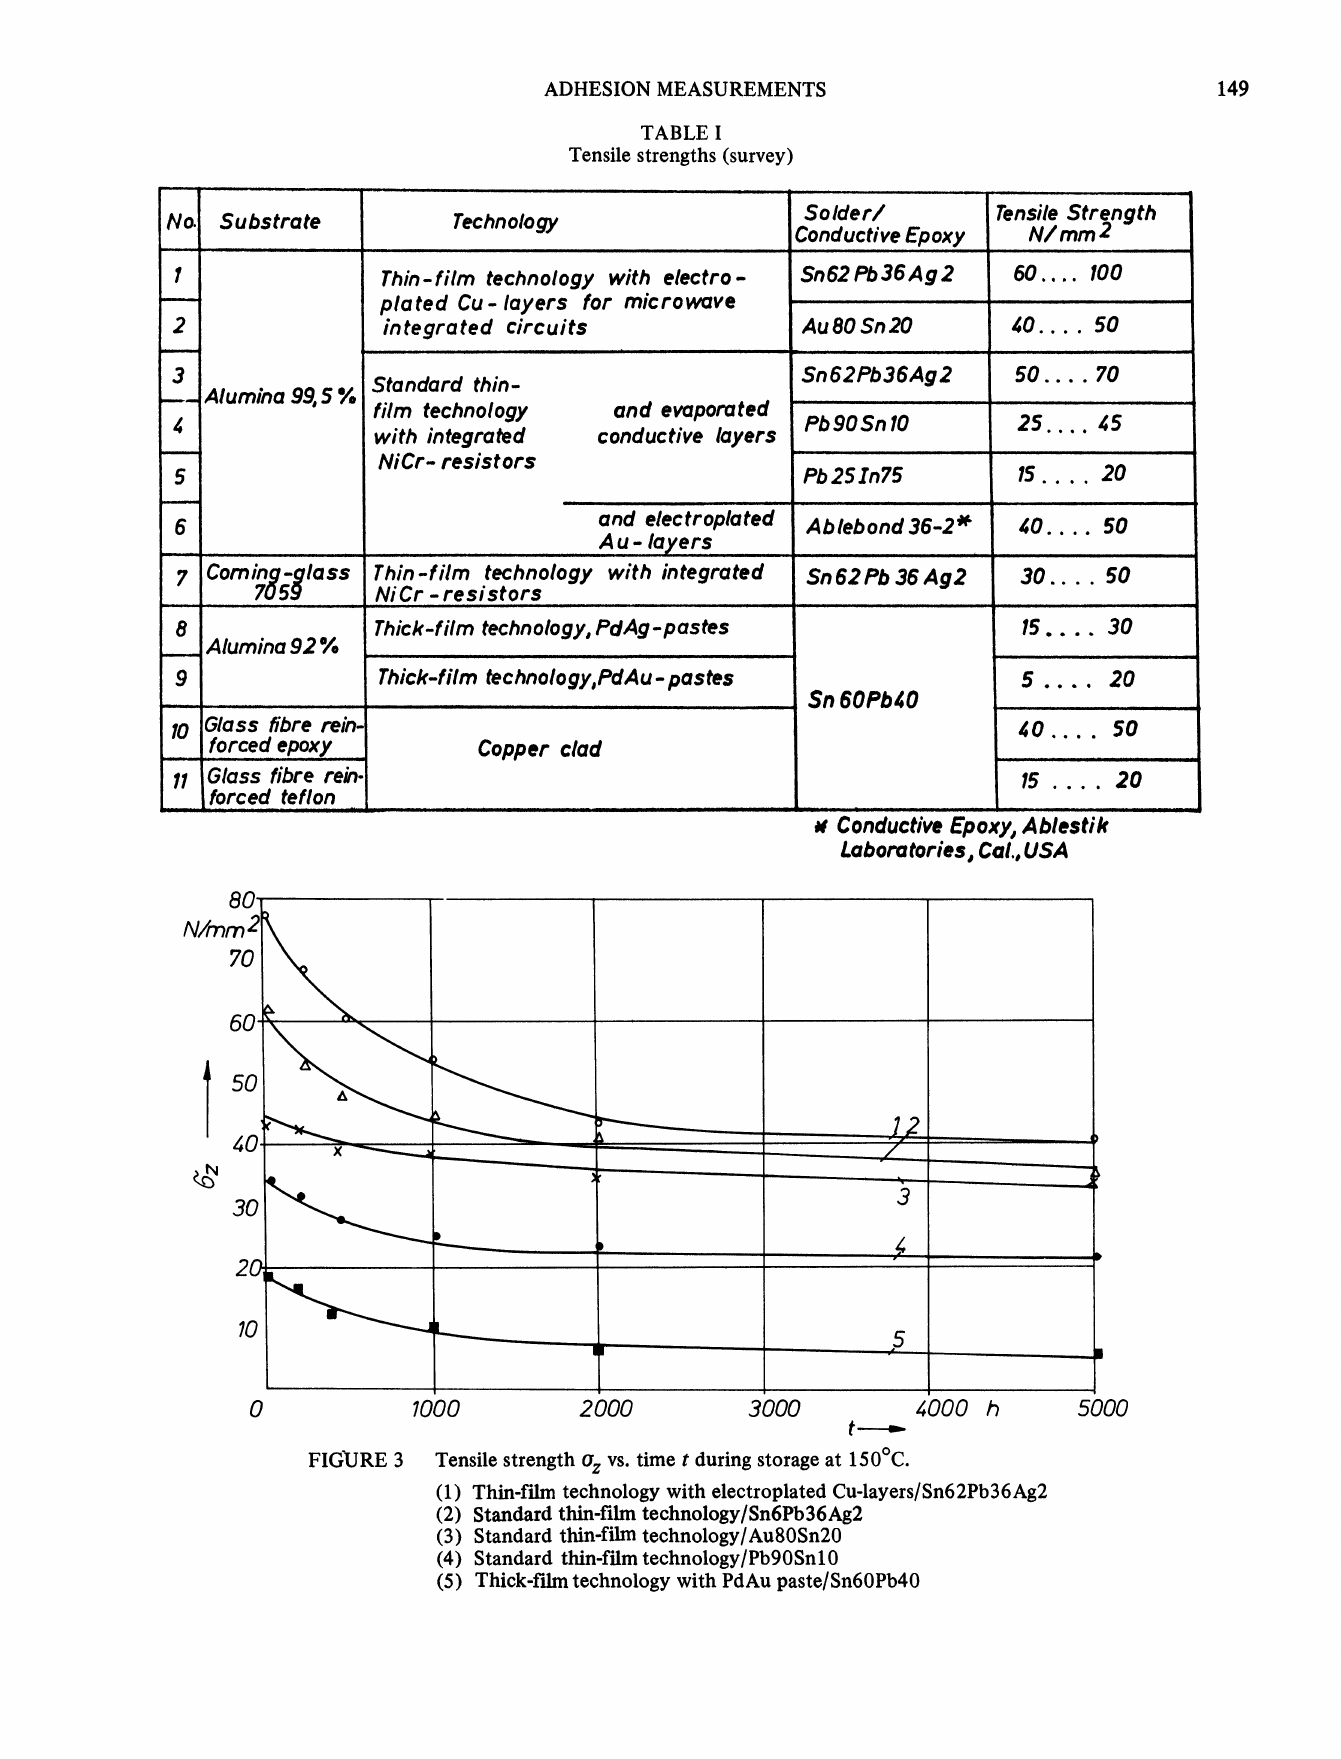
Tensile strength (r z vs. time during storage at 150C. (1) Thin-film technology with electroplated Cu-layers/Sn62Pb36 Ag2 (2) Standard thin-film technology/Sn6Pb36Ag2 (3) Standard thin-film technology/Au80Sn20 (4) Standard thin-film technology/Pb90Snl0 (5) Thick-f’tlm technology with PdAu